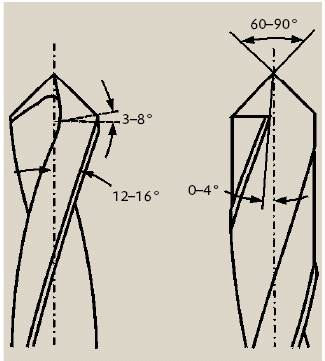
Figure 7: Geometry of drills for PMMA (Evonik Röhm